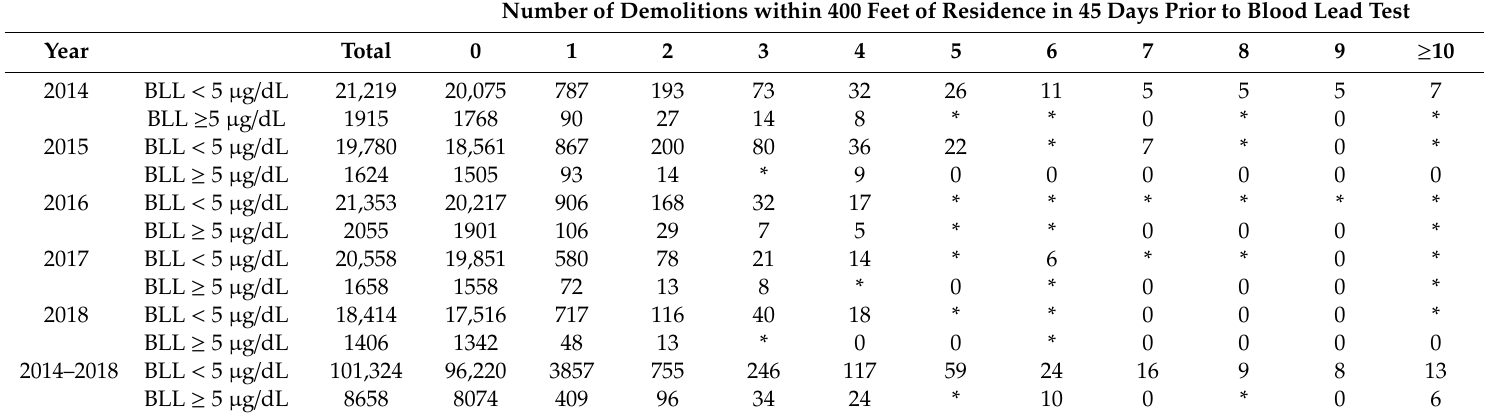
Table 2. Demolition exposure by children’s blood lead level, Detroit, 2014–2018 (N = 109,982